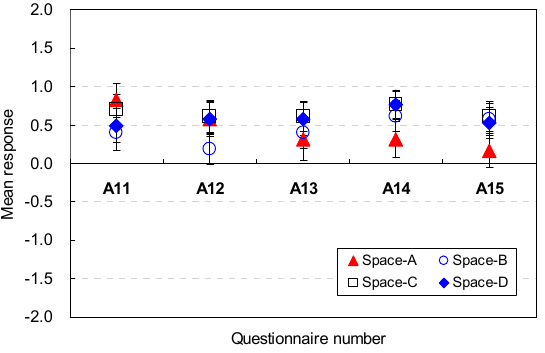
Figure 9. Spatial perception of the spatial configuration in terms of amenity under height changes.